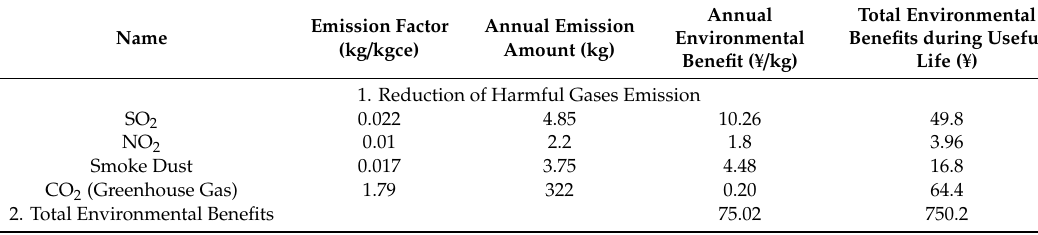
Table 2. Environmental benefits of a solar water heater per m 2 .